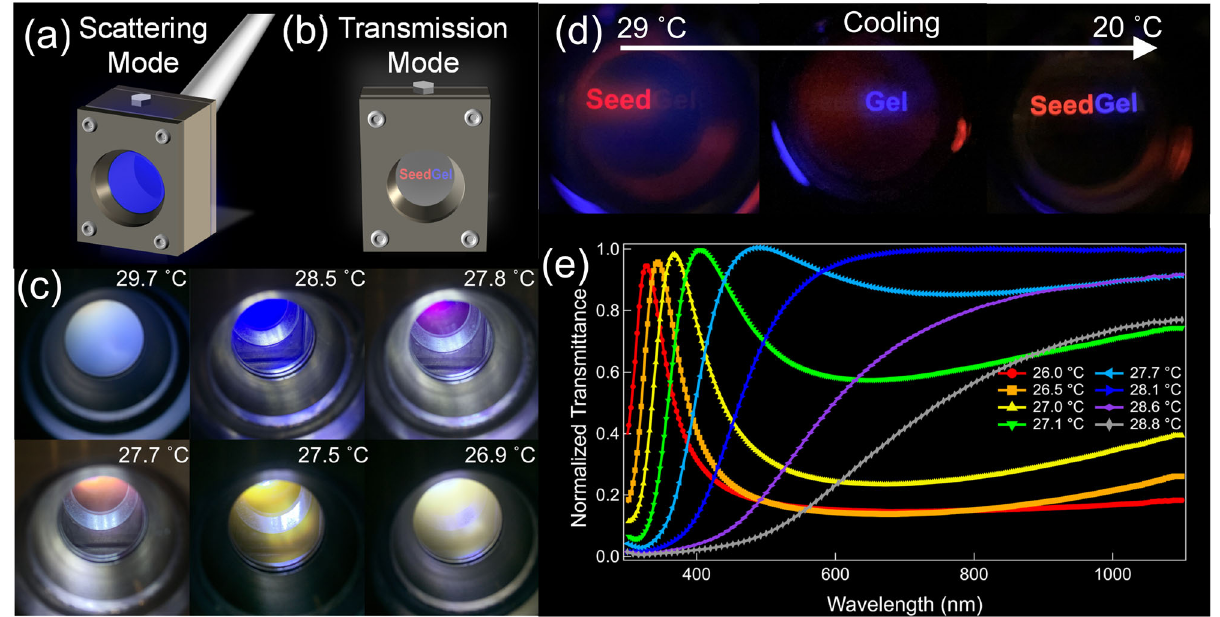
Fig. 1 Dynamically tunable coloration of SeedGel in both scattering mode and transmission mode. The schematic drawing illustrates the experimental setup in a scattering mode and b transmission mode. Photographs of SeedGel with c tunable structural color recorded in scattering mode at different temperatures and d temperature-dependent light transmission with different colors in transmission mode. A white light source is used in ( c ) and the colored word ‘ SeedGel ’ in red and blue in ( d ) is displayed on an OLED (organic light-emitting diode) screen. e Normalized transmittance of the SeedGel as a function of wavelength at different temperatures. An increase in temperature shifts the transmission peak towards a longer